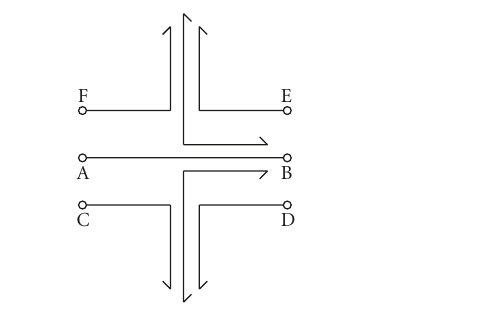
Figure 10: Schematic representation of the six-port, precision di- rectional coupler.